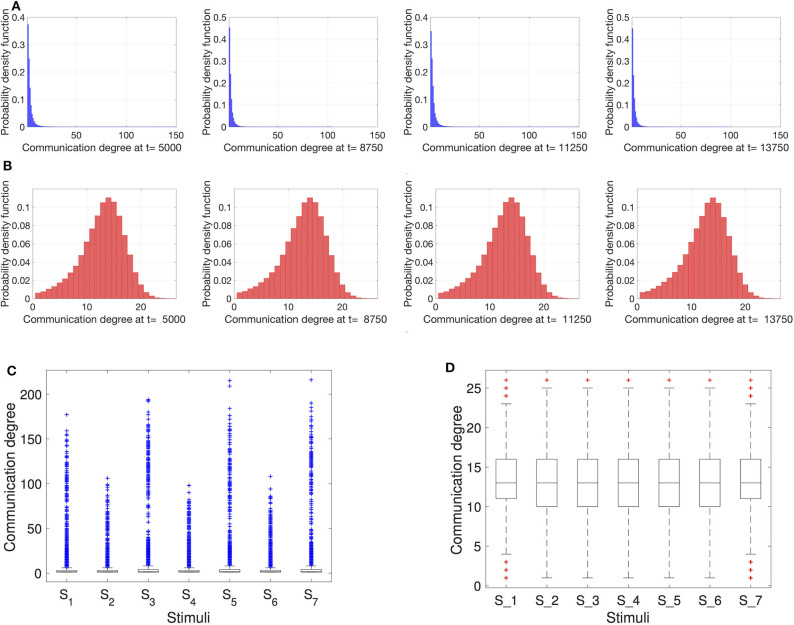
Degree distributions of the networks within the nest at different time instances. (A) Scale-free networks; (B) Proximity networks. At t = 5, 000 ts and t = 11, 250 ts there are Nitems = 30 to retrieve, while at t = 8, 750 ts and t = 13, 750 ts the item count is Nitems = 300. Additionally, box plots for the (C) scale-free and (D) proximity networks illustrate the presence of outliers for the different onsets of stimuli S1…7 (starting at tcrit = 7, 500 ts and occurring in intervals of Δtcrit = 2, 500 ts). As expected, in contrast to the proximity networks, in case of scale-free networks, the outliers (indicated by the + markers) are so extreme that the boxes containing the mean values are barely recognizable at the bottom of plot (C).